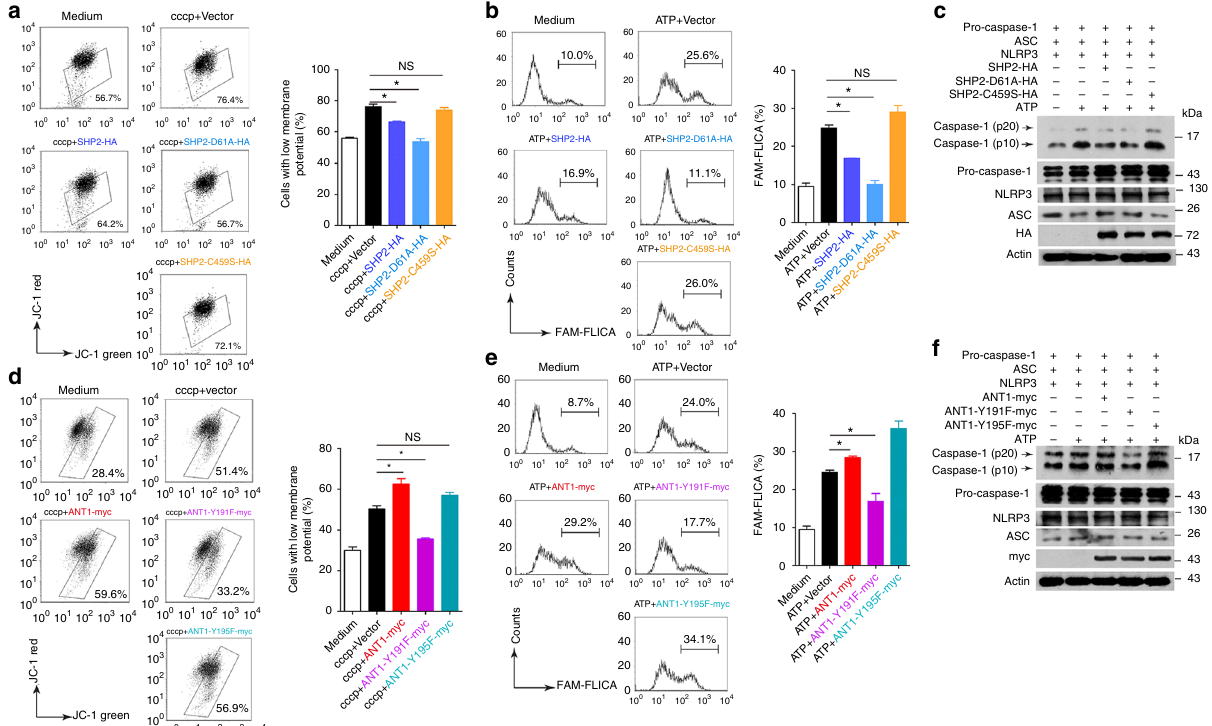
Fig. 9 SHP2 dephosphorylation of ANT1 at Tyr 191 is essential for mitochondrial homeostasis. a Flow cytometry analysis of mitochondrial membrane potential by JC-1 staining of HEK293T cells overexpressing Vector, SHP2-HA, SHP2-D61A-HA, or SHP2-C459S-HA plasmid and left untreated (medium) or treated with cccp (20 µ M, 1 h). b , c HEK293T cells were transfected with pro-caspase-1, ASC, NLRP3, and SHP2-HA, SHP2-D61A-HA, or SHP2-C459S- HA plasmid, respectively, followed by ATP (5 mM, 1 h) treatment. b Flow cytometry analysis of caspase-1 activation. c Immunoblot analysis of caspase-1 activation. d Flow cytometry analysis of mitochondrial membrane potential by JC-1 staining of HEK293T cells overexpressing Vector, ANT1-myc, ANT1- Y191F-myc, or ANT1-Y195F-myc plasmid and left untreated (medium) or treated with cccp (20 µ M, 1 h). e , f HEK293T cells were transfected with pro- caspase-1, ASC, NLRP3, and ANT1-myc, ANT1-Y191F-myc or ANT1-Y195F-myc plasmid respectively followed by ATP (5 mM, 1 h) treatment. e Flow cytometry analysis of caspase-1 activation. f Immunoblot analysis of caspase-1 activation. * P < 0.05, one-way ANOVA for multiple comparisons, NS represents no signi fi cance. Data are representative of three independent experiments (mean and SEM of three independent samples in a , b , d , e